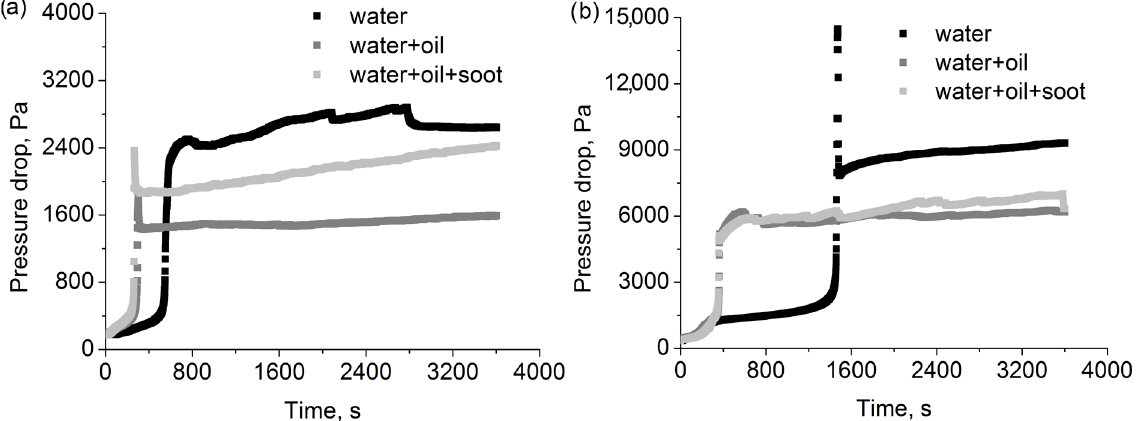
Figure 11. Pressure drop measured during filtration of various aerosols for ( a ) 2F6 and ( b ) F1 fil-